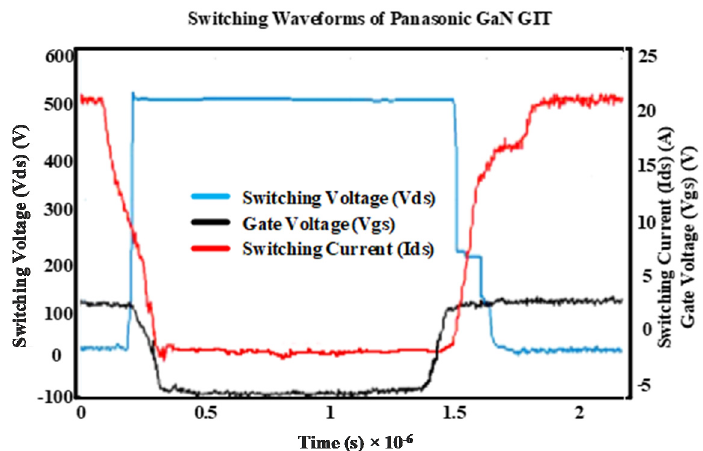
Figure 14. Switching waveforms for Panasonic GaN GIT.